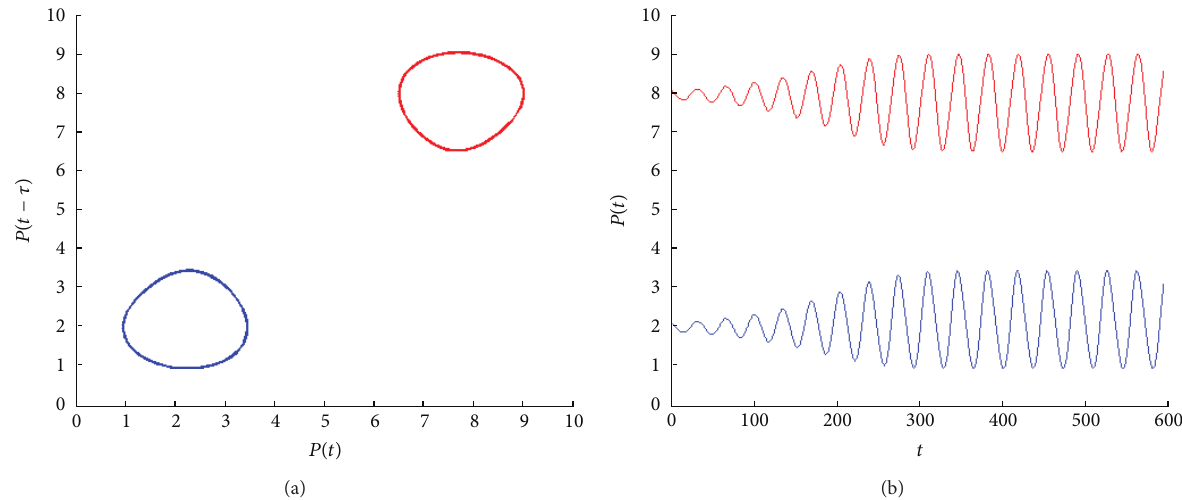
Figure 2: 𝜏 = 9 . (a) Two attracting closed invariant curves. (b) Corresponding time series with unique maximum and